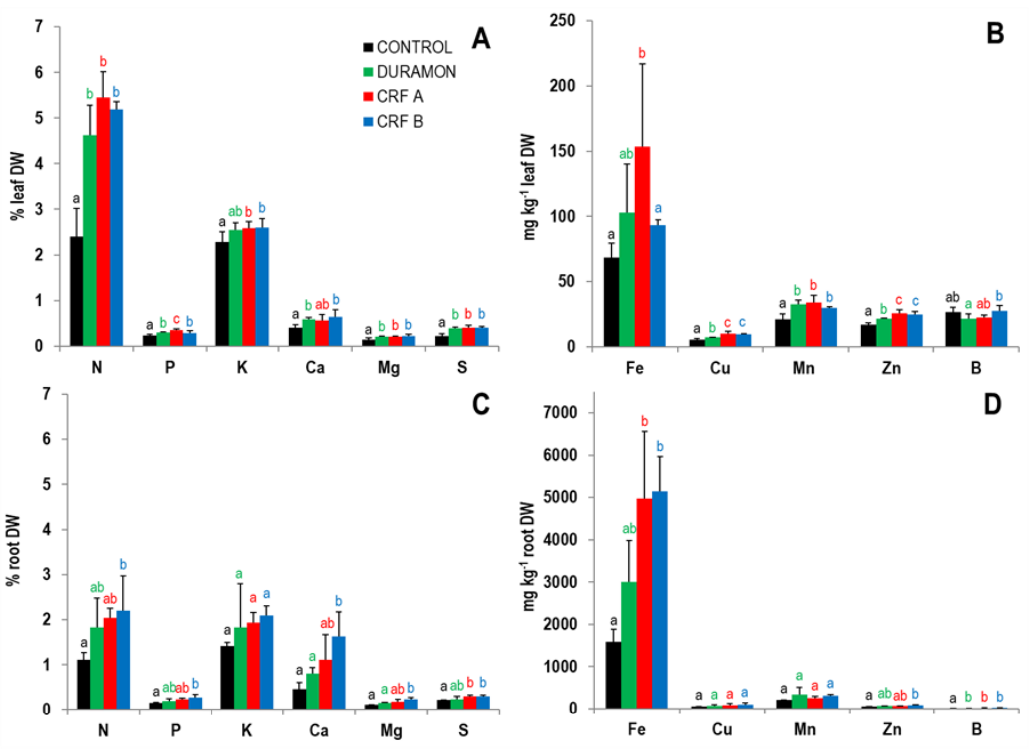
Figure 4. Macro- ( A , C ) and micronutrient ( B , D ) contents in leaves ( A , B ) and roots ( C , D ), for the different treatments with the polymeric-coated fertilizers (CRF A , CRF B ), DURAMON ® , and the CONTROL in the phenological state (booting stage). Results of macronutrients (N, P, K, Ca, Mg, and S) are expressed in percentage of DW, and micronutrients (Fe, Cu, Mn, Zn, B) in mg kg − 1 DW. Values are means ± SD ( n = 4). Different letters for a specific macro- or micronutrient in each panel indicate statistically significant differences between treatments (ANOVA, P < 0.05).